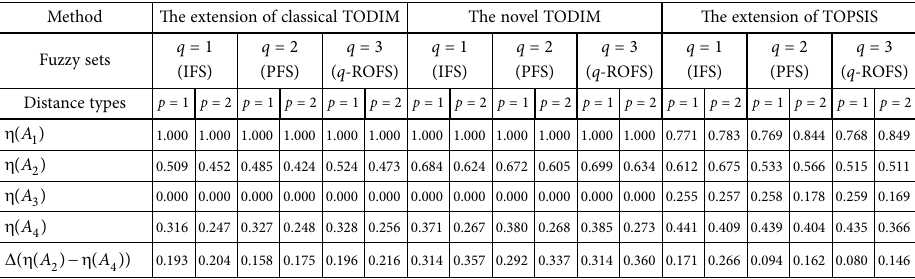
Table 19. The results of 14 combinations Method The extension of classical TODIM The novel TODIM The extension of